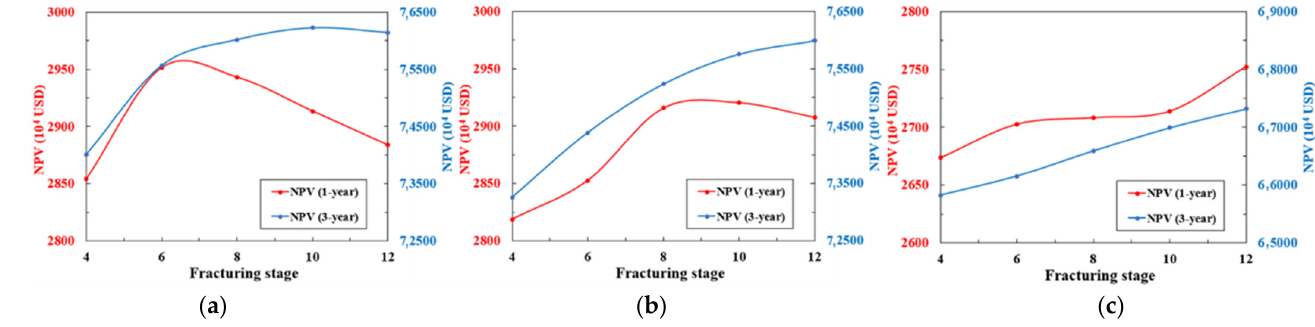
Figure 11. NPV of reservoir stimulation in ( a ) Type I, ( b ) Type II, ( c ) Type